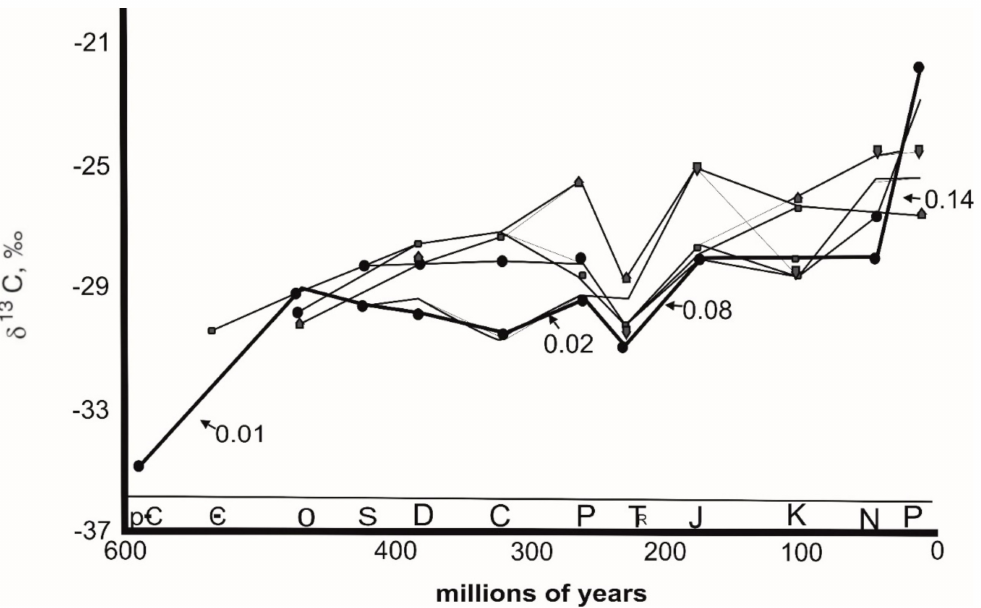
Figure 6. Stable carbon isotope composition of crude oils versus geologic age (Reproduced. from [88] with permission from